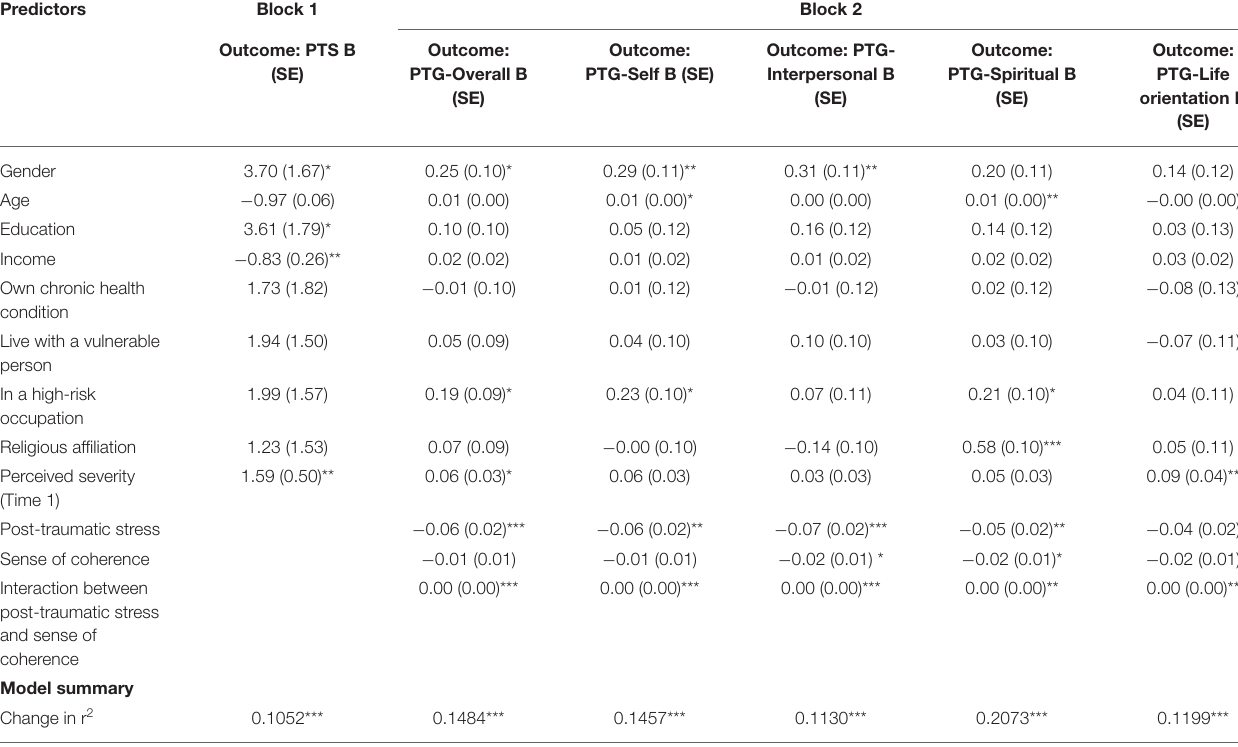
TABLE 3 | Moderated mediation models on post-traumatic growth and subscales ( N =